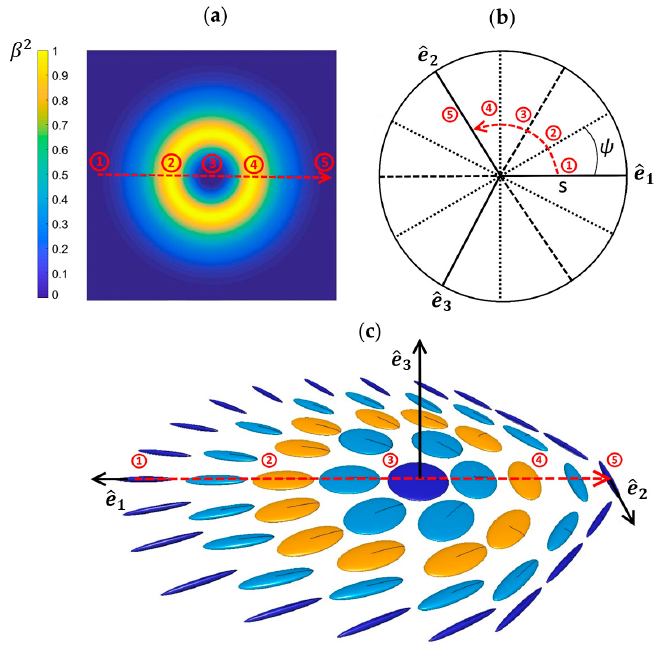
Figure 2. Core structure of a typical m = 1 / 2 disclination. ( a ) The biaxial spatial variation, measured via the biaxiality parameter β 2 (see Equation (3)). The core structure is characterized by a rim, where β 2 = 1. The rim is circular in the approximation of equal elastic constants. The center of the core exhibits negative uniaxiality. ( b ) Characteristic changes in the ( s , ψ ) phase space on crossing the center of disclination. ( c ) Schematic variation of the nematic mesoscopic local profile within the core. Here numbers 1 to 5 mark points representing mesoscopic changes on traversing the defect core along a chosen direction.